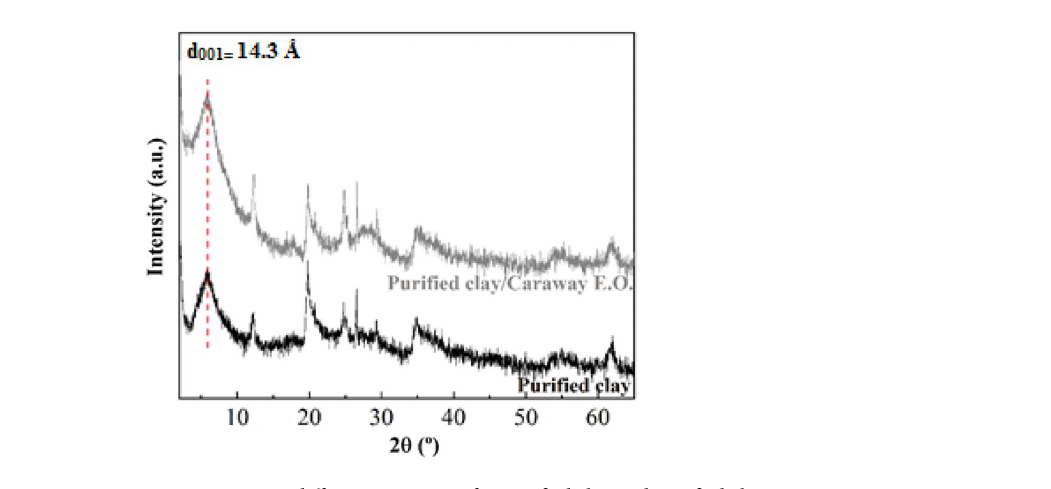
Figure 9. X-ray diffraction patterns for purified clay and purified